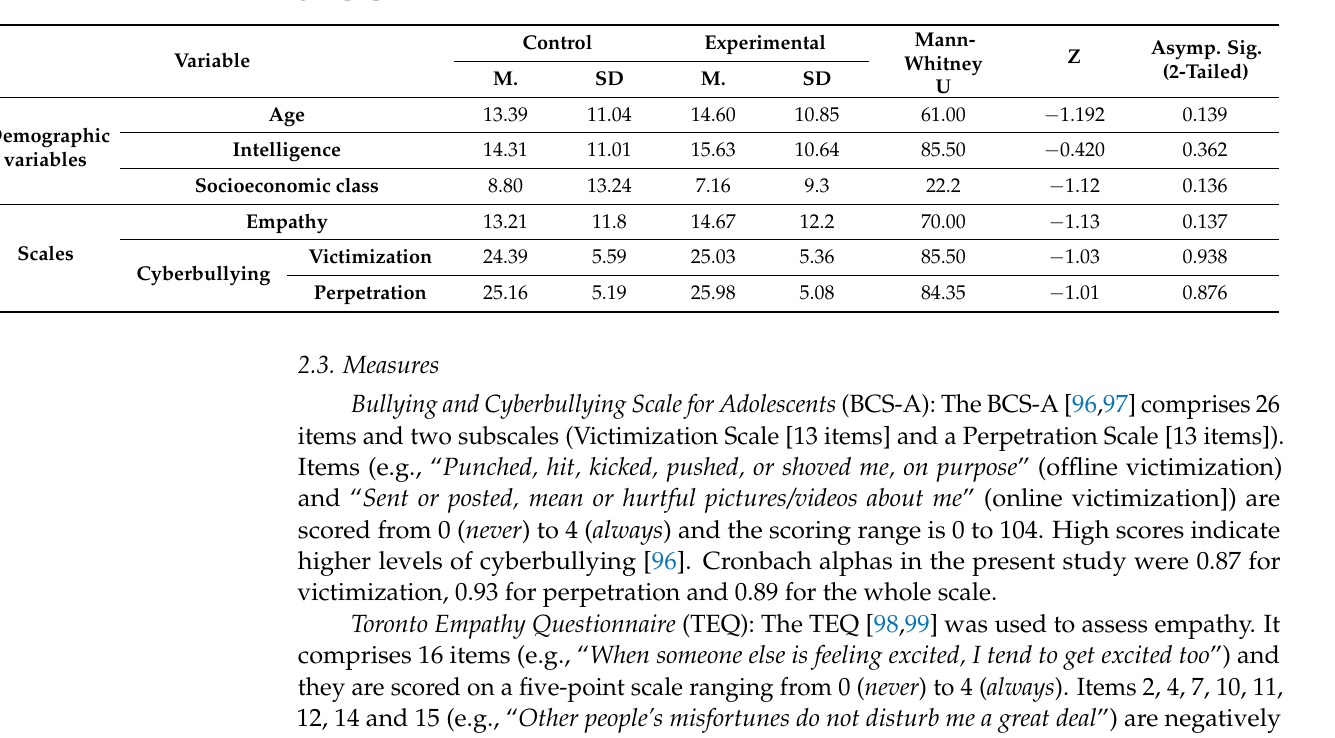
Table 1. Mean scores and values of (U) and (Z) in the variables of the study (age, socioeconomic class, general intelligence, empathy and cyberbullying) for the control ( n = 119) and experimental ( n = 98) groups prior to the